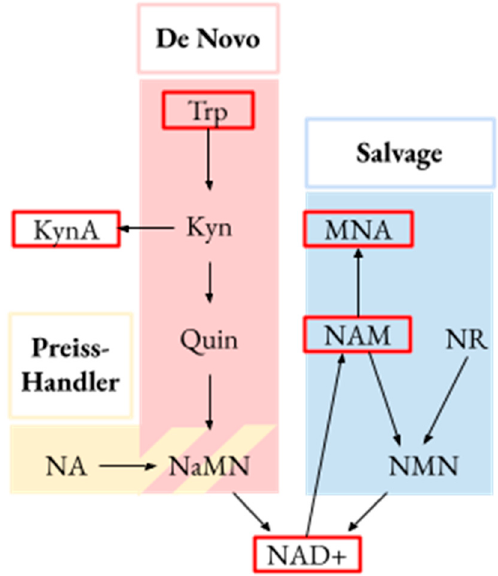
Figure 1. Key metabolic pathways connected to NAD+. De novo from tryptophan (Trp), salvage from nicotinate riboside (NR) and nicotinamide (NAM), and Preiss–Handler from nicotinic acid. Metabolites evaluated in this study are identified by a red border. Kyn, kynurenine; KynA, kynurenic acid; NaMN, nicotinate mononucleotide; NA, nicotinic acid; NAD+, nicotinamide adenine dinucleotide; MNA, methylnicotinamide; NMN, nicotinamide mononucleoside.